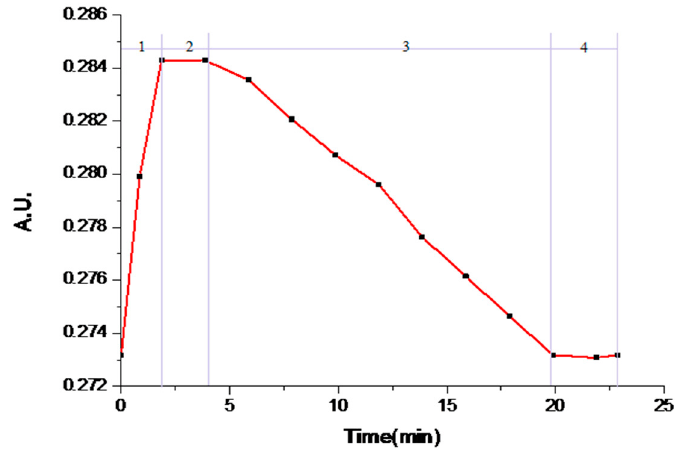
Figure 7. Solution concentration change of famoxadone in Experiment